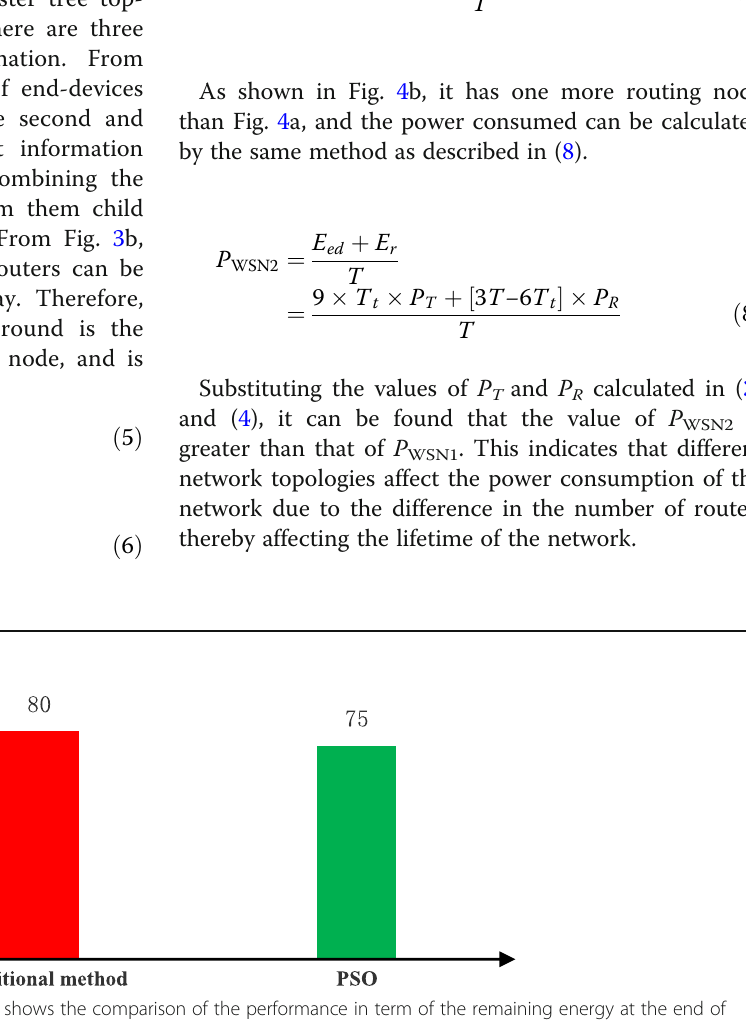
Fig. 10 Comparison of remaining energy. This figure shows the comparison of the performance in term of the remaining energy at the end of network